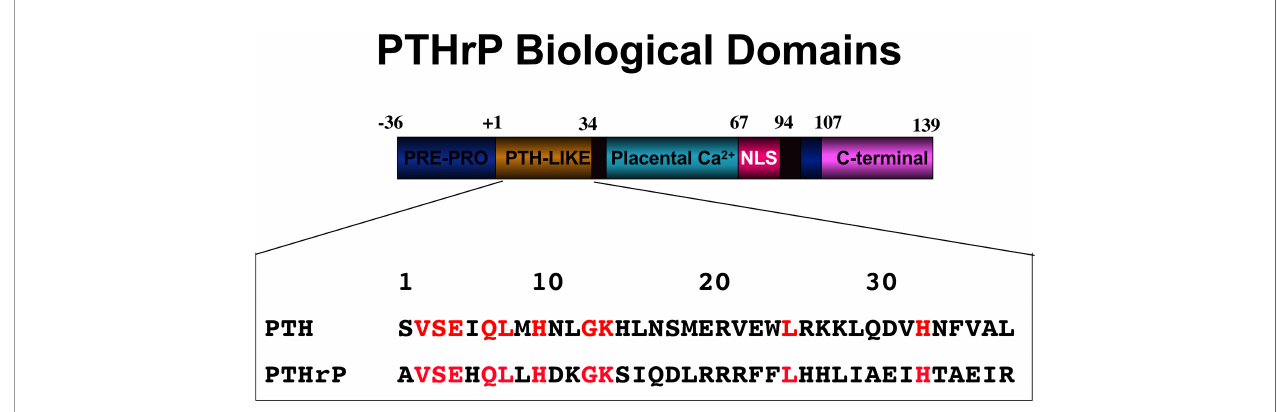
FIGURE 4 | PTHrP biological domains. The amino-terminal domain of PTHrP acts like PTH upon the PTH1R. Identical residues within PTHrP and PTH are indicated in red. The other domains of action within PTHrP